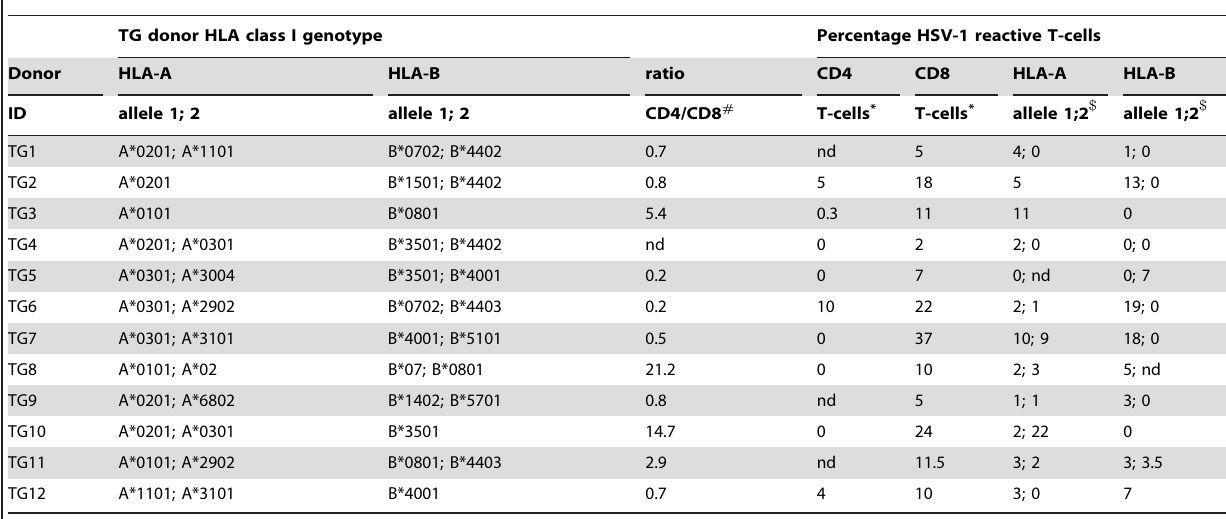
Table 1. Phenotype and HLA class I allele restriction of HSV-1 reactive T-cells recovered from human TG.